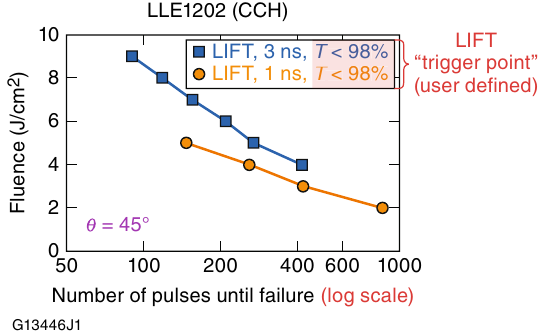
Figure 8. LIFT results for LLE1210 at 351 nm for both 1-ns and 3-ns laser pulses delivered at a 5-Hz repetition rate. The high saturation of this CCH-based LC material allows it to withstand nearly 1000 pulses at 2 J/cm 2 .